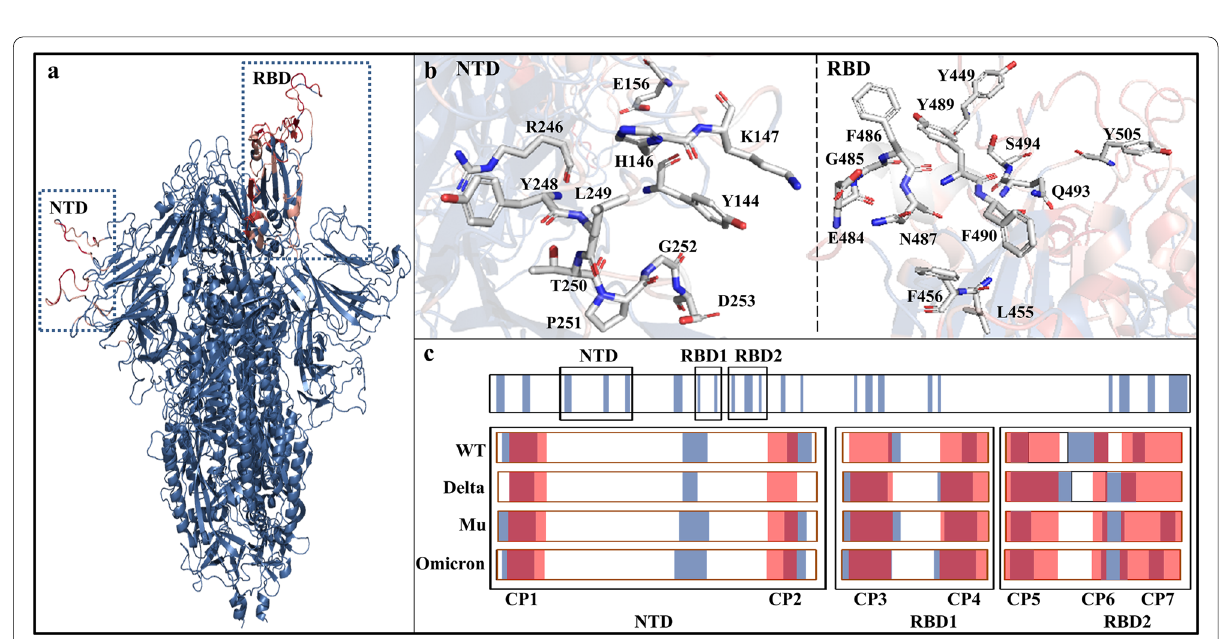
Fig. 3 Continuous epitopes analysis of SP. a In SP complexes with antibody, the depth of red color indicates the occurrence probability in the interaction residues between SP and antibodies; b the possible CPs with occurrence probability over 35% from structural biology statistics; c the prediction result with BepiPred-2.0 are colored in blue, the statistical data form RCSB PDB are colored in red, and the overlapped part is the final determined CPs